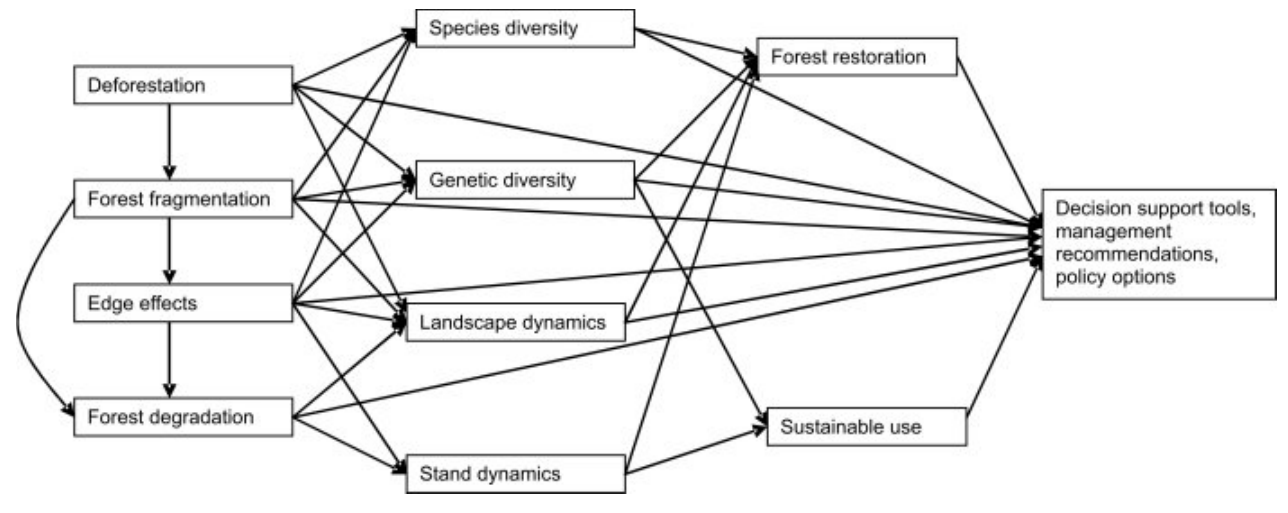
Fig. 2. Relationship between research themes investigating the impacts of human activities on forest biodiversity in Latin America. The text boxes represent the main research themes implemented in the research projects described in the main text. Arrows represent information flow. The research themes addressed different impacts of human activities on different elements of forest biodiversity, together with selected response options, to inform the development of sustainable management